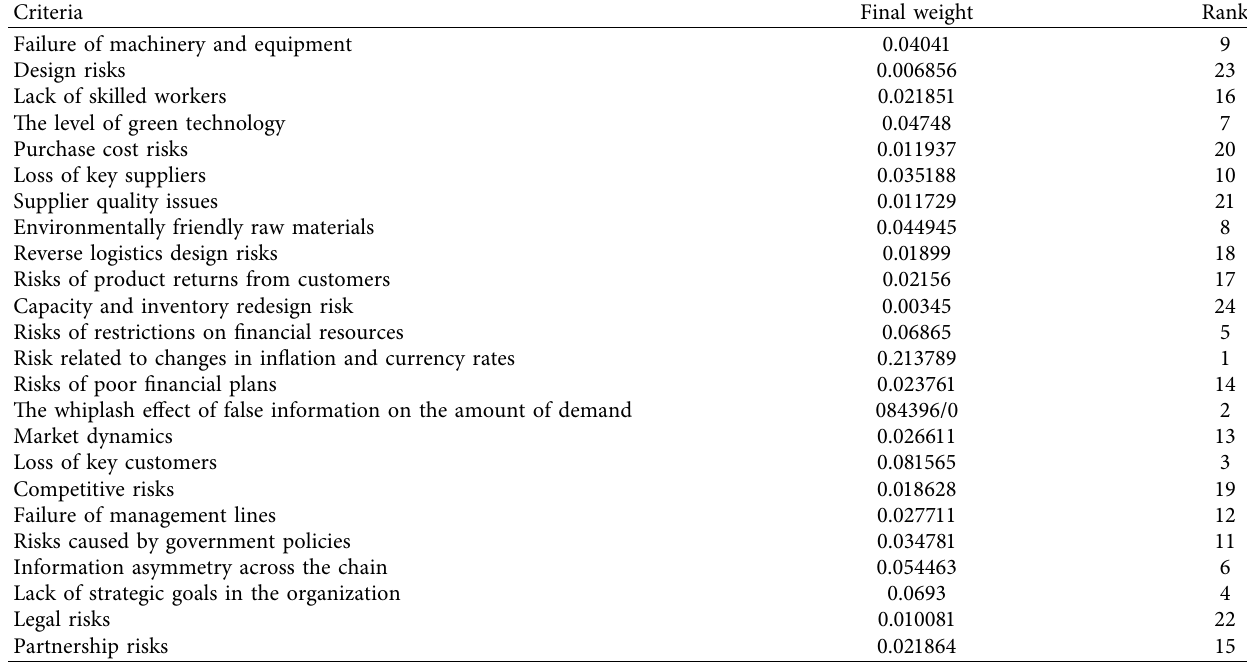
Table 13: Ranking of green supply chain risk criteria.